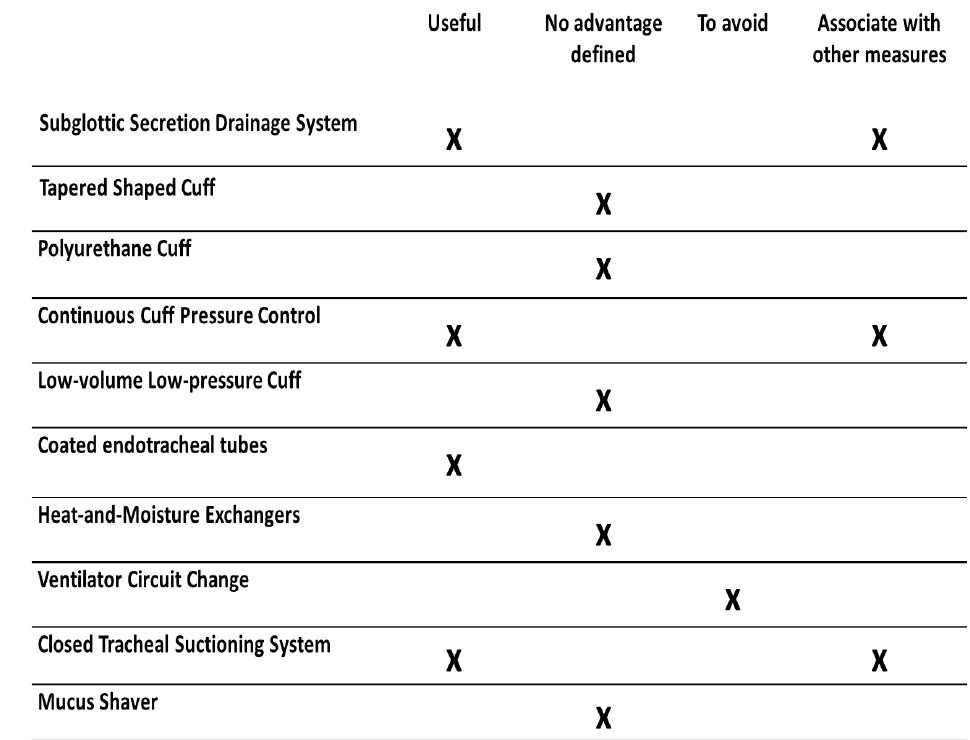
Figure 1. The usefulness of airway and respiratory devices in the prevention of ventilator-associated pneumonia.